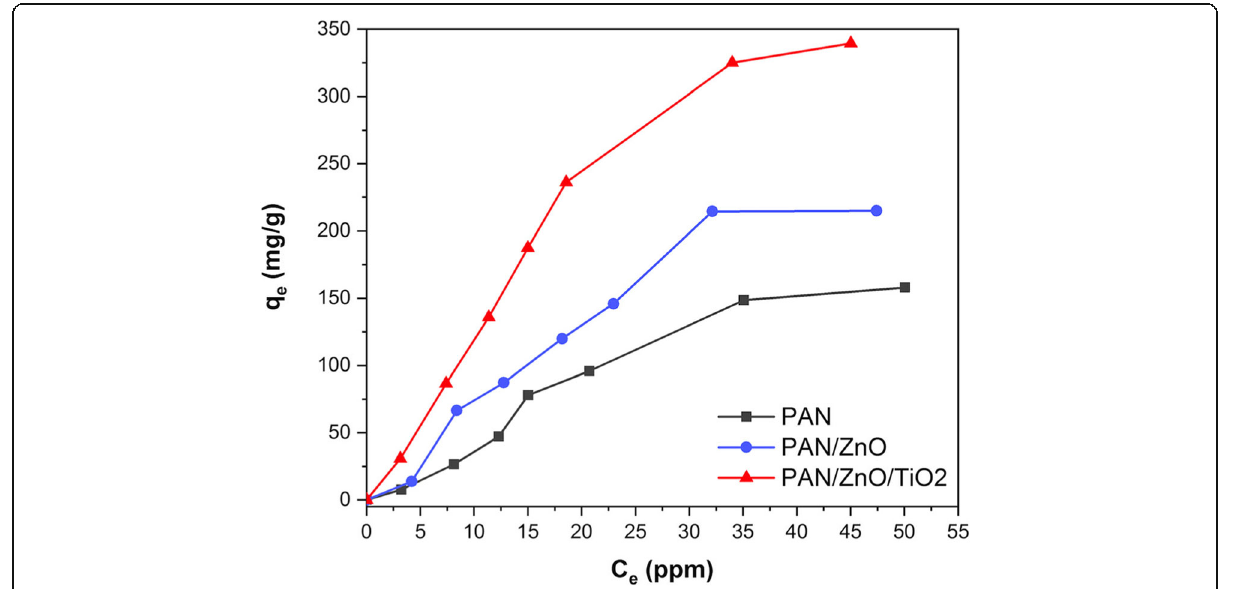
Fig. 8 Adsorption isotherm of Cr (VI) into PAN based n- fib@Mats as a function of initial Cr (VI) concentration